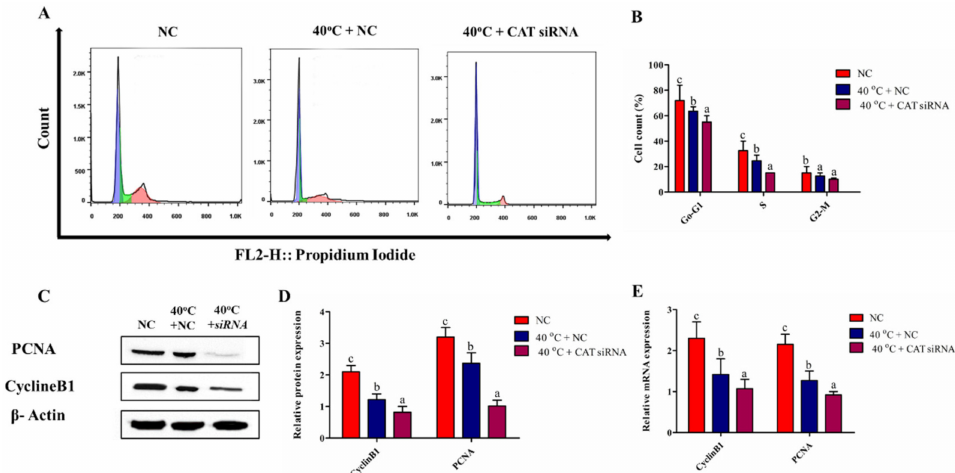
Figure 6. CAT regulates cell cycle distribution in GCs under HS. Flow cytometric profiles showed di ff erences in cell cycle among treatment groups ( A , B ). The protein expressions of PCNA and CyclinB1 were analyzed by Western blotting ( C , D ). Moreover, the mRNA expression of PCNA and CyclinB1 from GCs of the NC and treated groups (40 ◦ C + NC and 40 ◦ C + CAT si RNA) were evaluated by RT-qPCR ( E ). Values are expressed as mean ± SEM of n = 3. Superscripts (a, b, c) represent a significant ( p < 0.05) di ff erence.